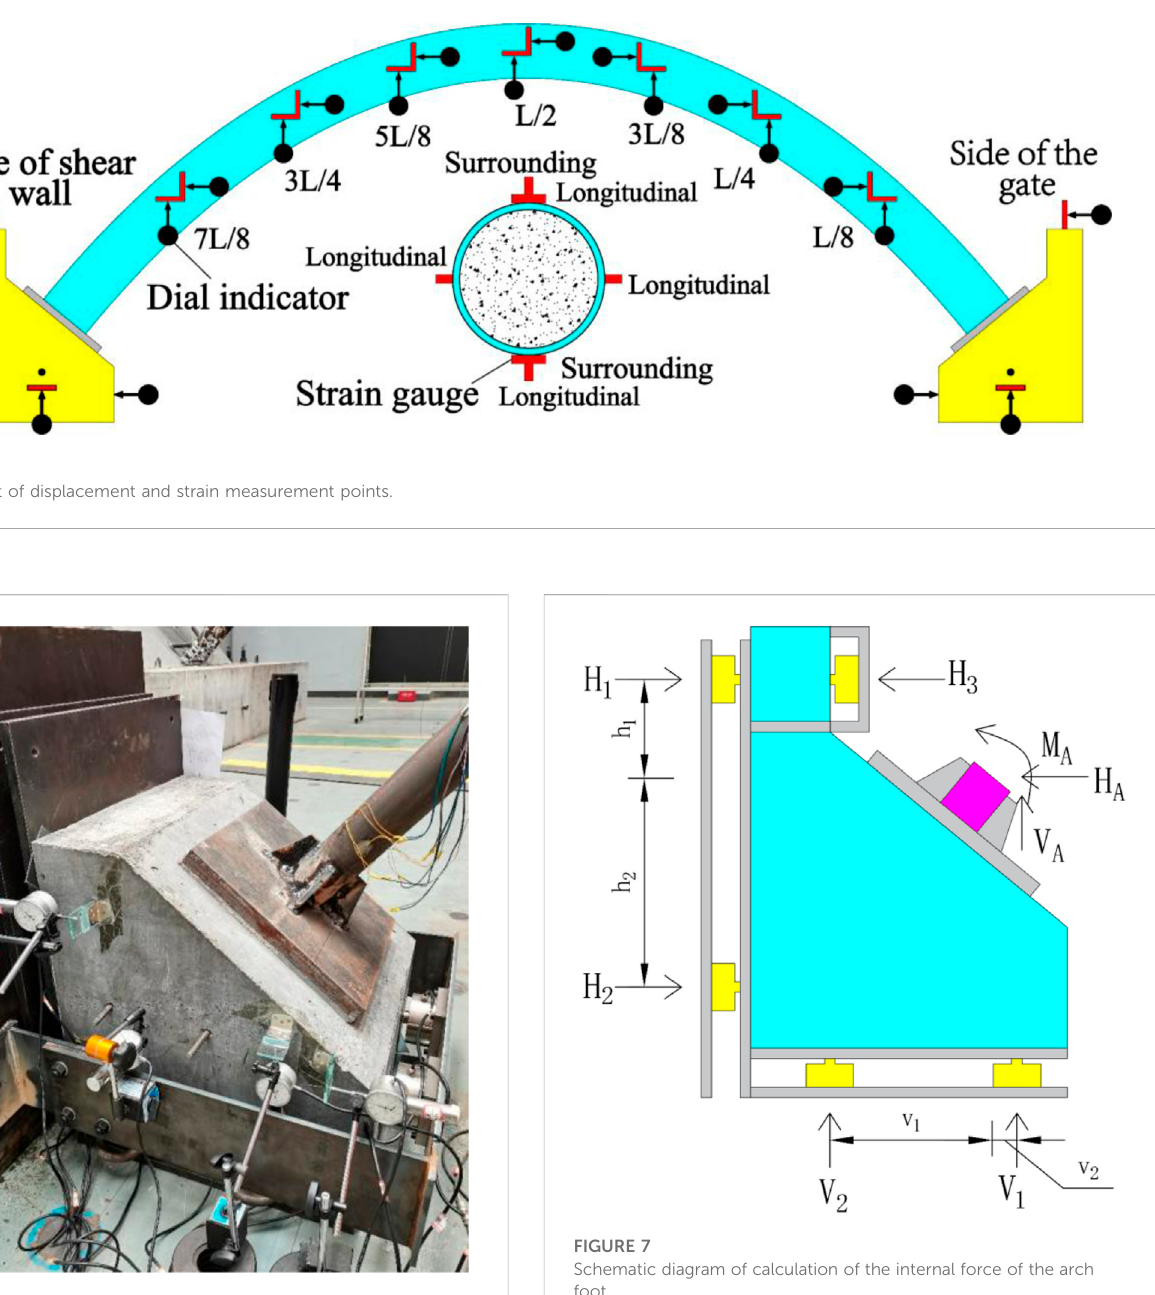
FIGURE 6 Four-point loading skewback.